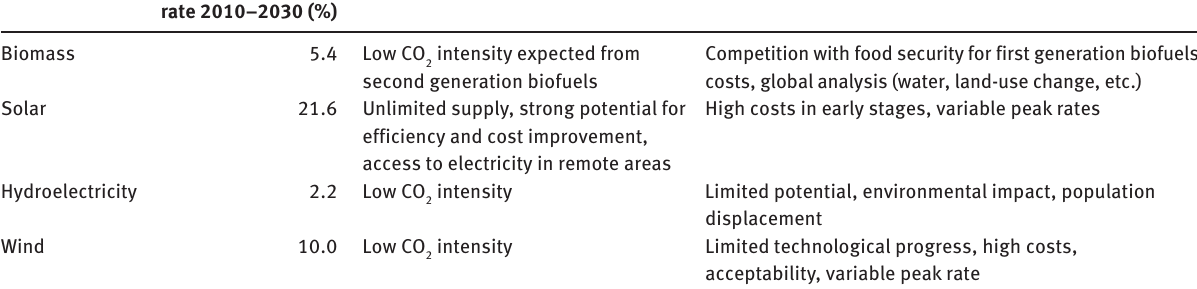
Table 2 2010 – 2030 growth rates and benefits/drawbacks of biomass, solar, hydroelectricity, and wind. Source: TOTAL S.A.